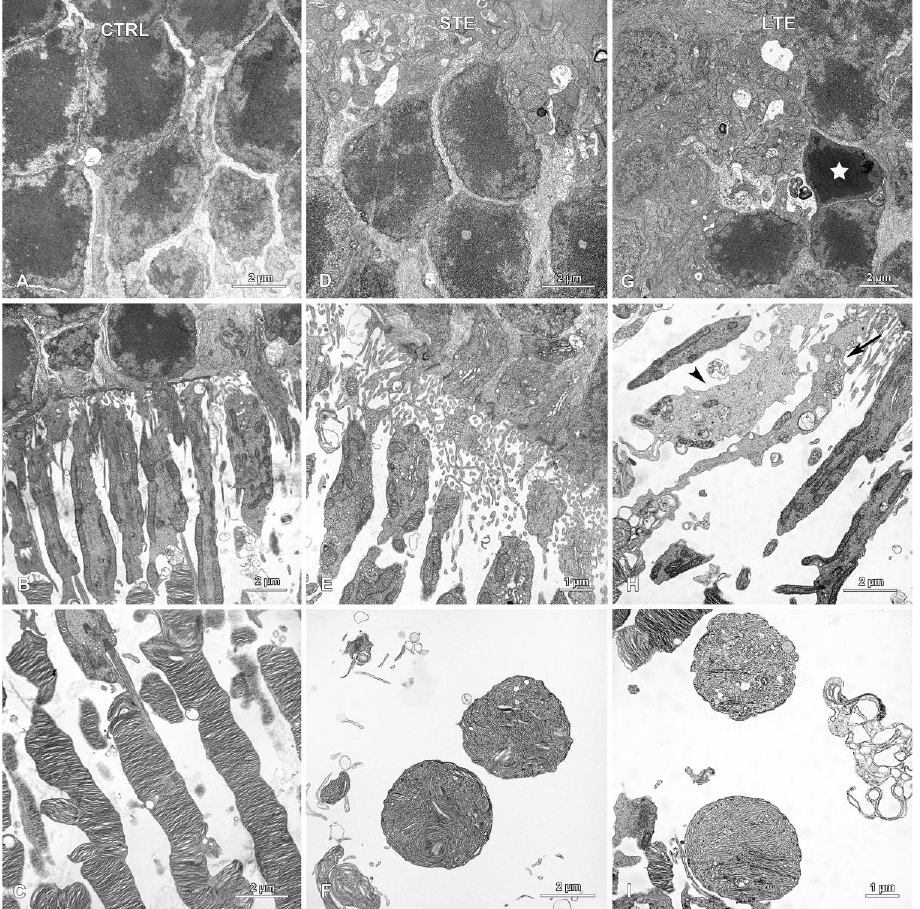
Figure 10. Effect of blue light exposure on the morphology of photoreceptors. Electron micrographs of retinas from Wistar rats. The rats were exposed to 12 h white light (150 lx) and 12 h darkness for 10 d (control, CTRL; 9 rats), cycles of 12 h blue light (150 lx) and 12 h darkness for 10 d (long-term exposure, LTE; 9 rats), and constant blue light (150 lx) for 2 d (short-term exposure, STE; 9 rats). Normal looking outer nuclear layers (ONL) in the ( A ) control and ( D ) STE groups. ( G ) ONL from the LTE group. Note: a single nucleus with pyknotic chromatin (star) present among normal looking nuclei in the ONL. Normal looking photoreceptor outer and inner segments from the ( B ) control and ( E ) STE groups. ( H ) Inner segments from the LTE group display some abnormalities. Note: some inner segments are thinner and longer (arrow), and some are swollen and thicker and have a lighter cytoplasm (arrowhead) than those in the control group. ( C ) Normal looking photoreceptor outer segments in the control group. In the ( F ) STE and ( I ) LTE groups, the apical parts of the pho- toreceptor outer segments form round or ellipsoidal structures containing tubules and vesicles.